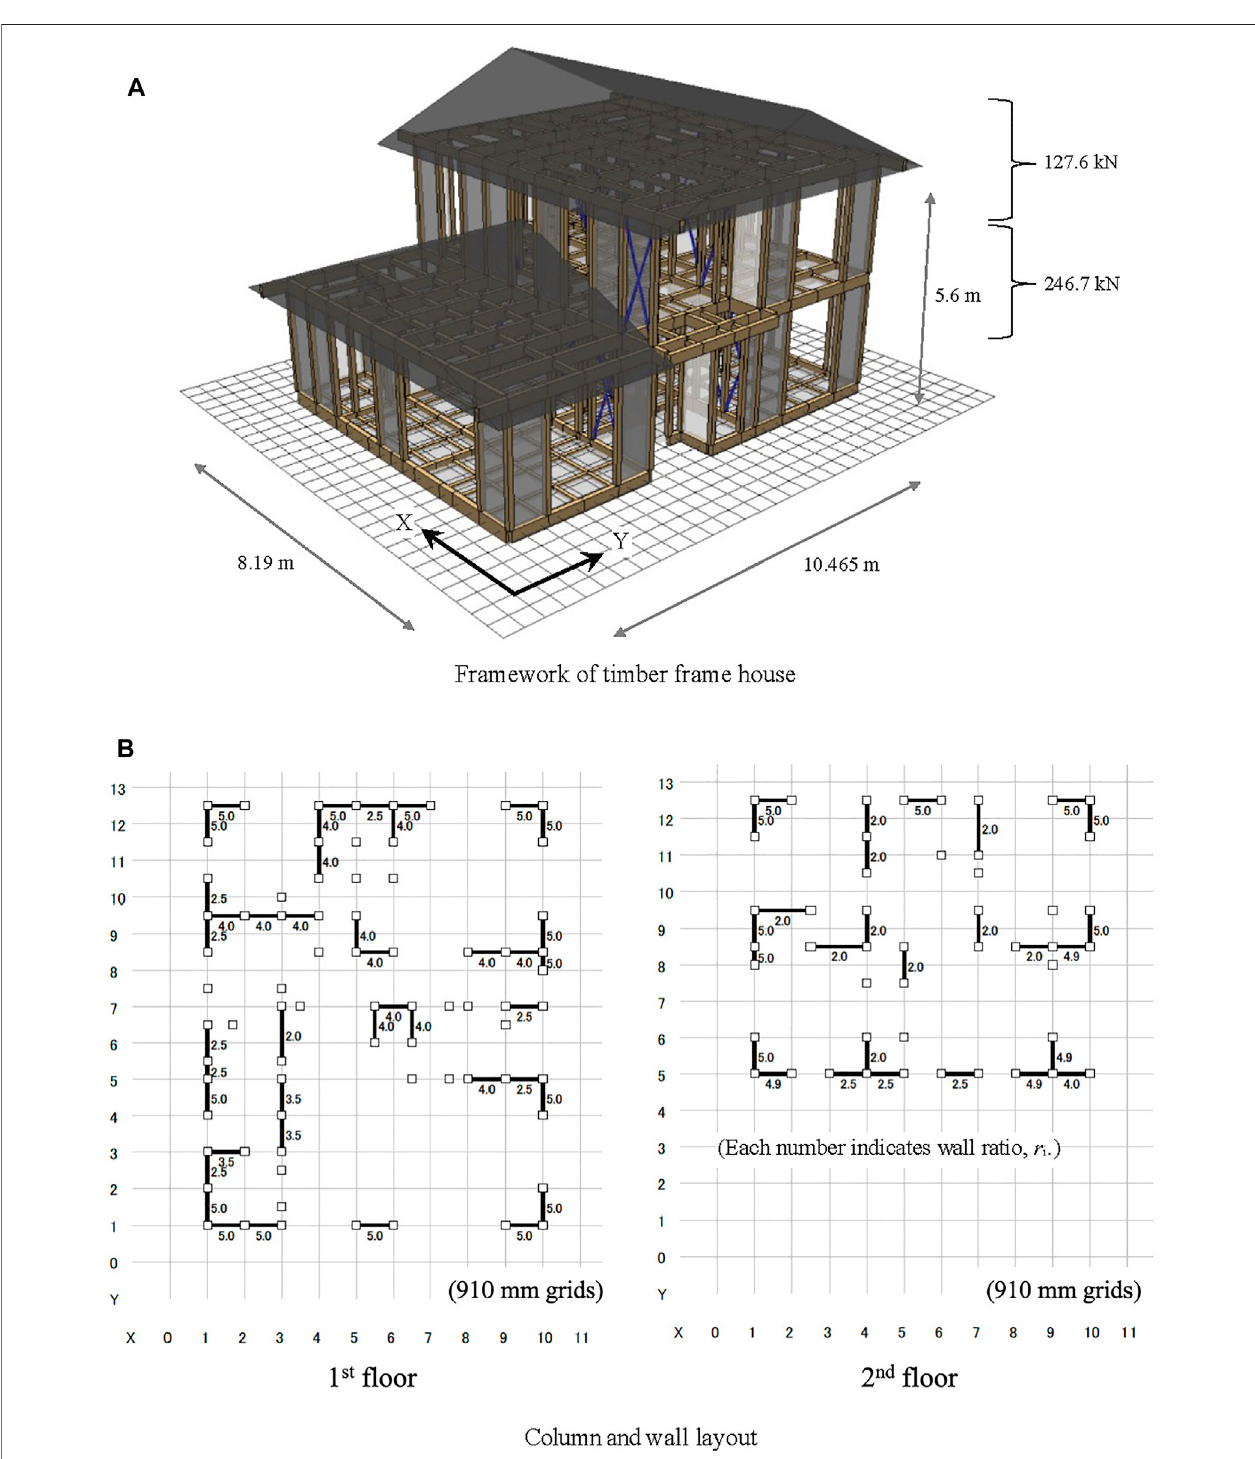
FIGURE 6 | Timber frame house for earthquake response analyses. (A) Framework of timber frame house. (B) Column and wall layout.